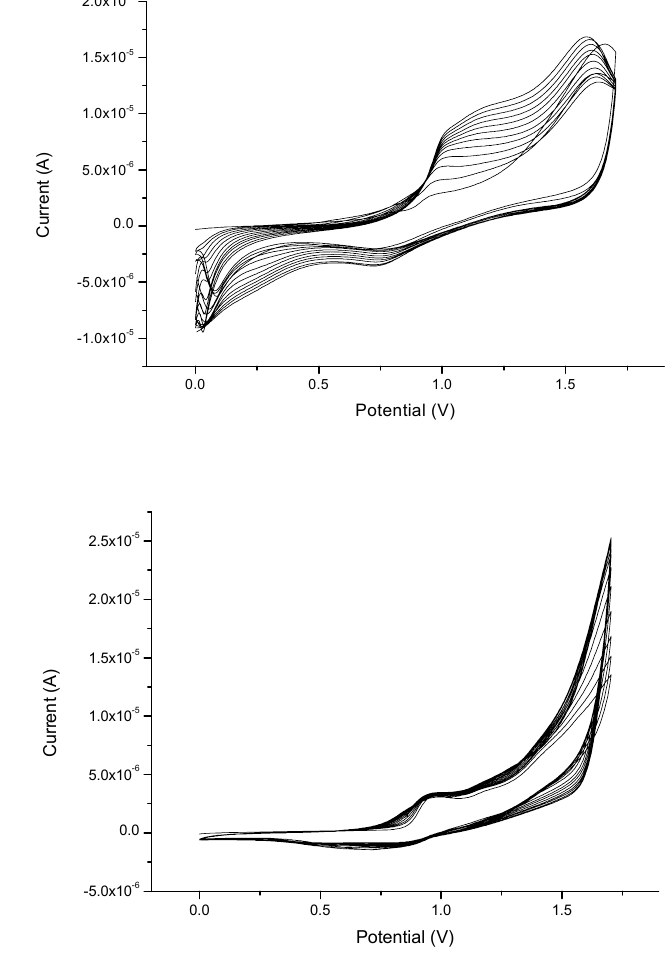
Cyclic voltammograms of investigated monomers: ( A ) electropolymerization of 2,6-bis(3,4-ethylenedioxythiophene)-4-methyl-4-octyl-dithienosilole and ( B ) electropolymerization of 2,6-bis(selenophen-2-yl)-4-methyl-4-octyl-dithienosilole (monomers concentration: 1mM) in 0.1 M tetrabutylammonium-tetrafluoroborate (TBA-TFB). Measurement conditions: scan rate 50 mV / s, Ag / AgCl—reference electrode, 15 cycles.